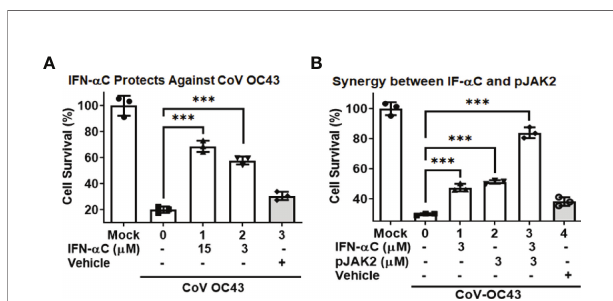
FIGURE 5 | IFN- a C peptide protects against cell toxicity caused by human coronavirus OC43. (A) RD cells were pre-treated with the indicated concentrations of IFN a − C or vehicle for one hour followed by infection with HuCoV-OC43 at MOI of 0.1 for 1 hour. Cells were washed with PBS and incubated in low serum media containing the same amount of peptide for 72 hours. Cell viability was assessed using the CellTiter kit (Promega). (B) RD cells were pre-treated with IFN- a C, pJAK2 or a combination of the two at 3 m M for one hour and infected with CoV-OC43 at MOI of 0.1 for one hour. The cells were then treated as in (A) . ***p<0.0001 between different concentrations of pJAK2 peptide and virus